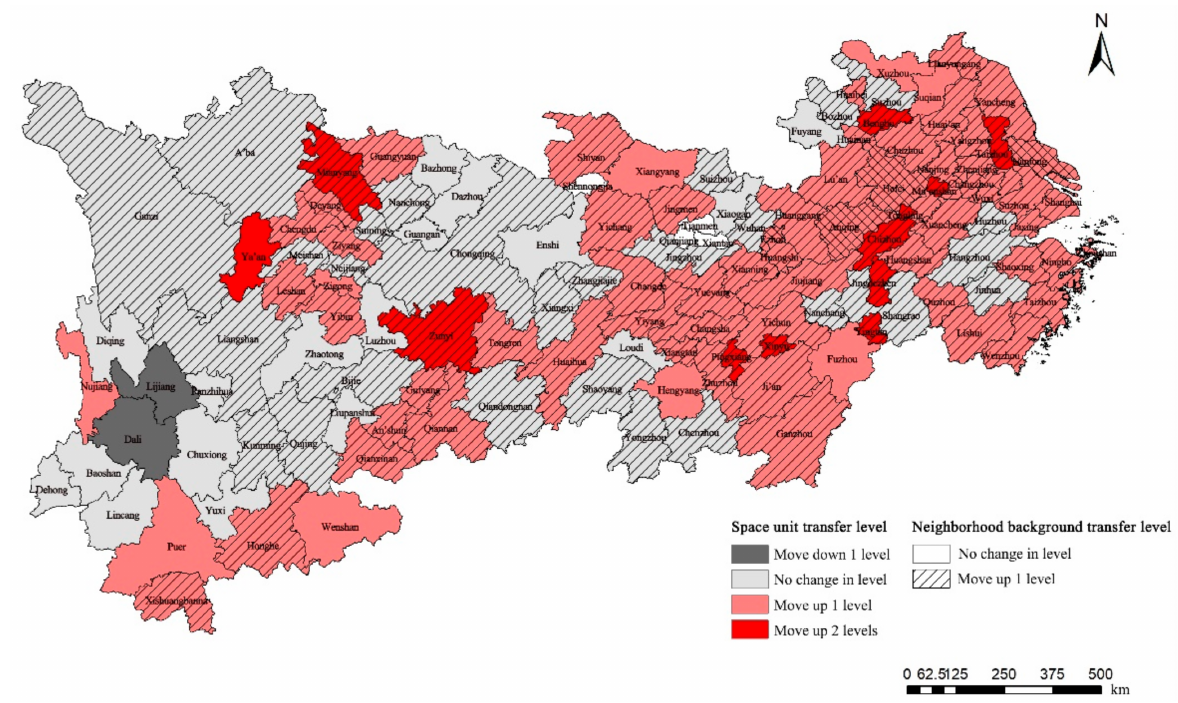
Figure 6. Distribution of the class changes of spatial units and their neighborhood,